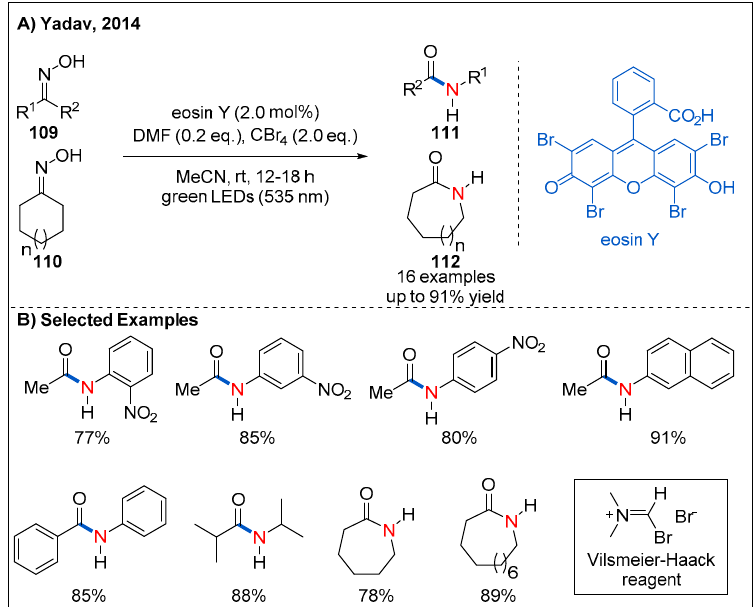
Figure 33. Photoinduced Beckmann rearrangement.